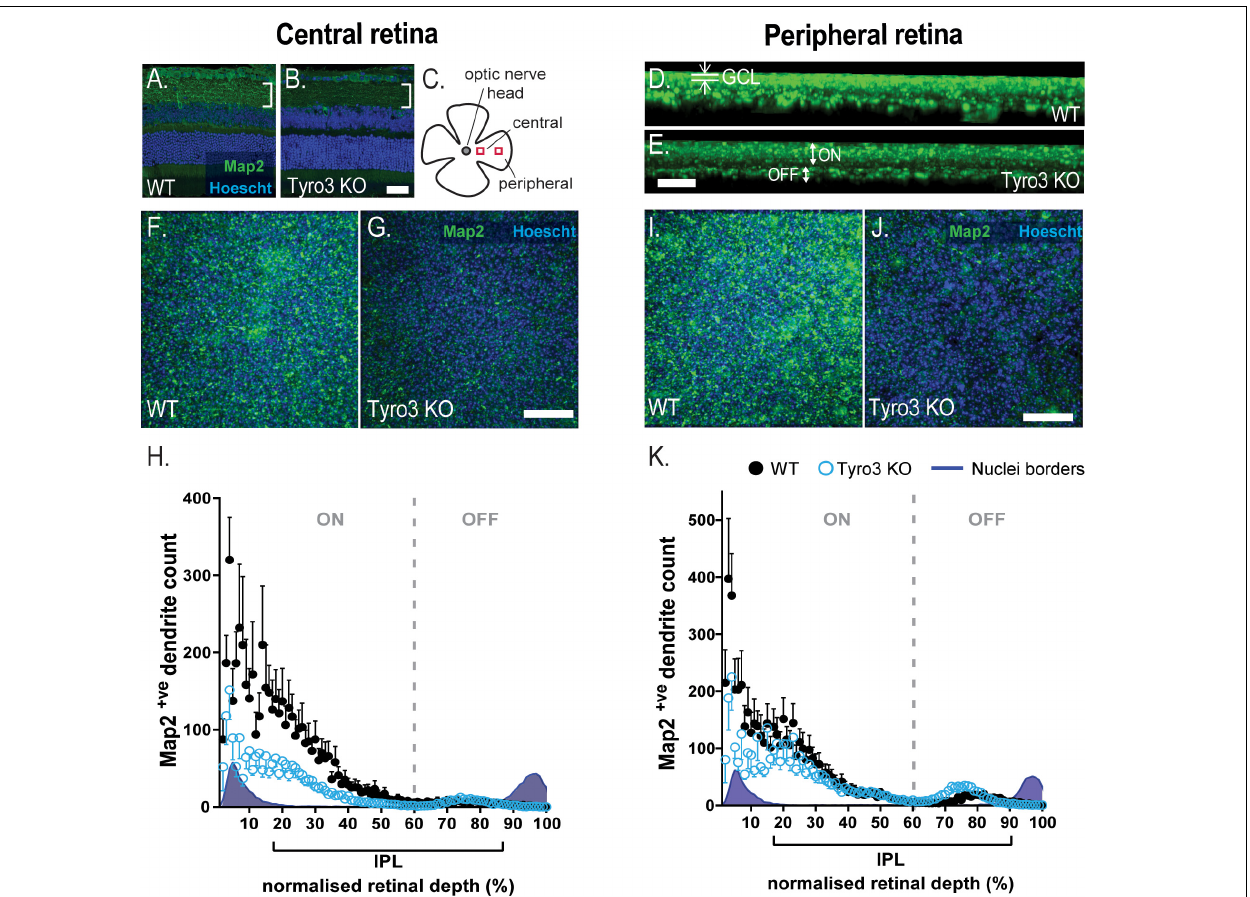
FIGURE 4 | Loss of Tyro3 results in fewer RGC dendrites in the IPL. The density of dendrites within the inner plexiform layer (IPL) was assessed in the retinas of Tyro3 KO ( n = 8) and WT mice ( n = 6). Dendrites were visualized with fluorescent immunohistochemistry against Map2 (green). Boundaries of the inner plexiform layer (IPL) were defined by the nuclei layers counter-stained with Hoechst (blue). Cross-sectional representative images (A,B) and a schematic of the region of interest are shown (C) . Representative, z-axial images of WT and Tyro3 KO Map2 staining are shown (D,E) , highlighting the ganglion cell layer (GCL) and ON- OFF-dendritic regions. Flattened, transverse images from whole mount retinae from both WT and Tyro3 KO mice from the central (F,G) and peripheral region are shown (I,J) . Dendrite counts were expressed relative to the depth of the IPL, defined by the nuclei borders. Significantly fewer Map2 + ve dendrites were found in the IPL in the central ( H , p < 0.0001) and peripheral ( K , p < 0.0001) retina of Tyro3 KO mice compared to WT controls. Numerical results are presented as mean ± SEM, statistical significance was calculated using repeated measures ANOVA. Scale bars = 50 µ